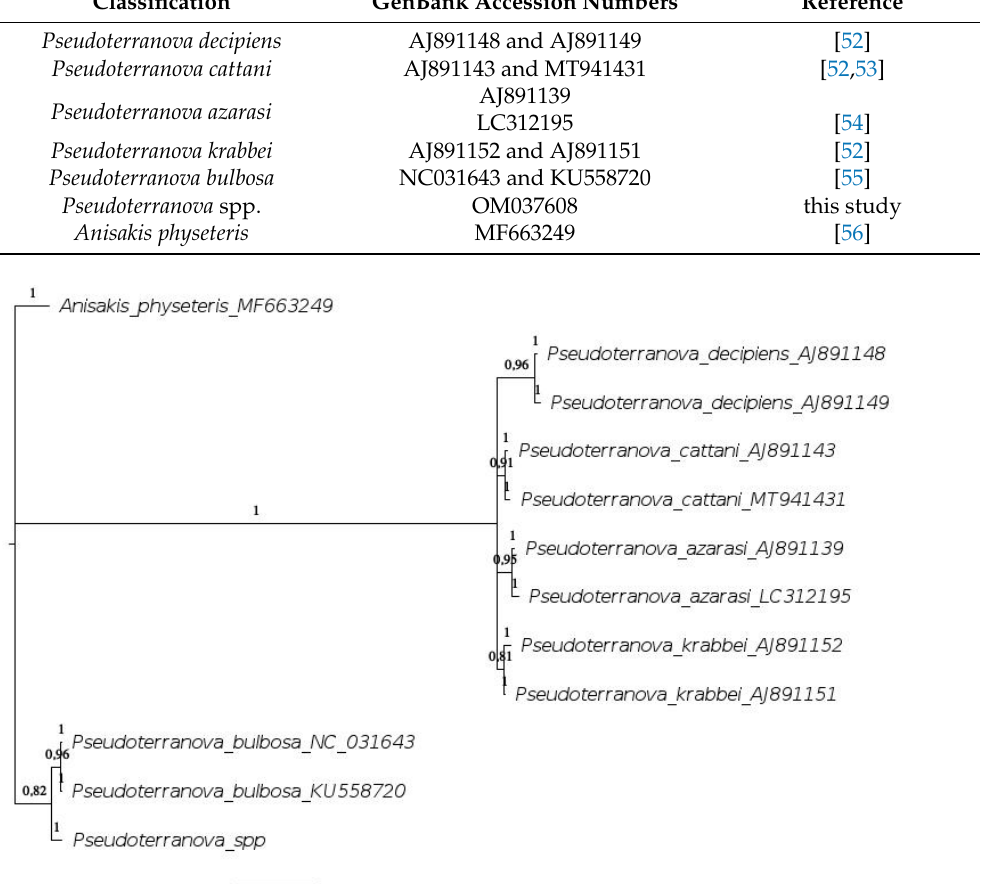
Figure 2. Phylogenetic tree generated from Bayesian Inference (BI) analysis of sequences of the COI